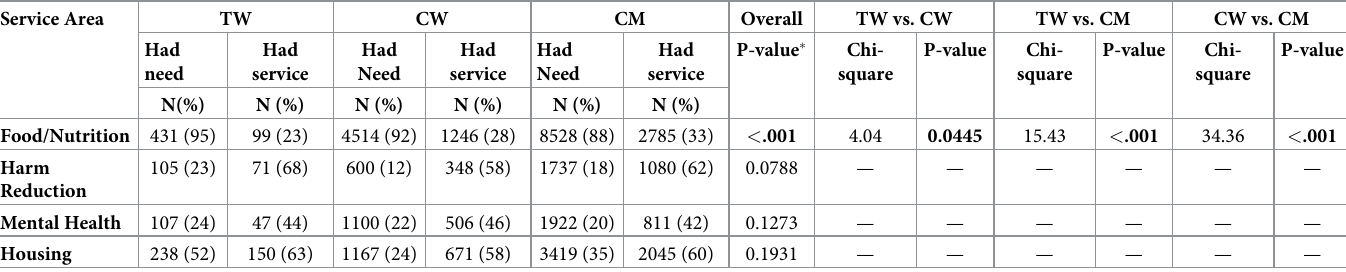
TW, transgender women; CW, cisgender women; CM, cisgender men. �